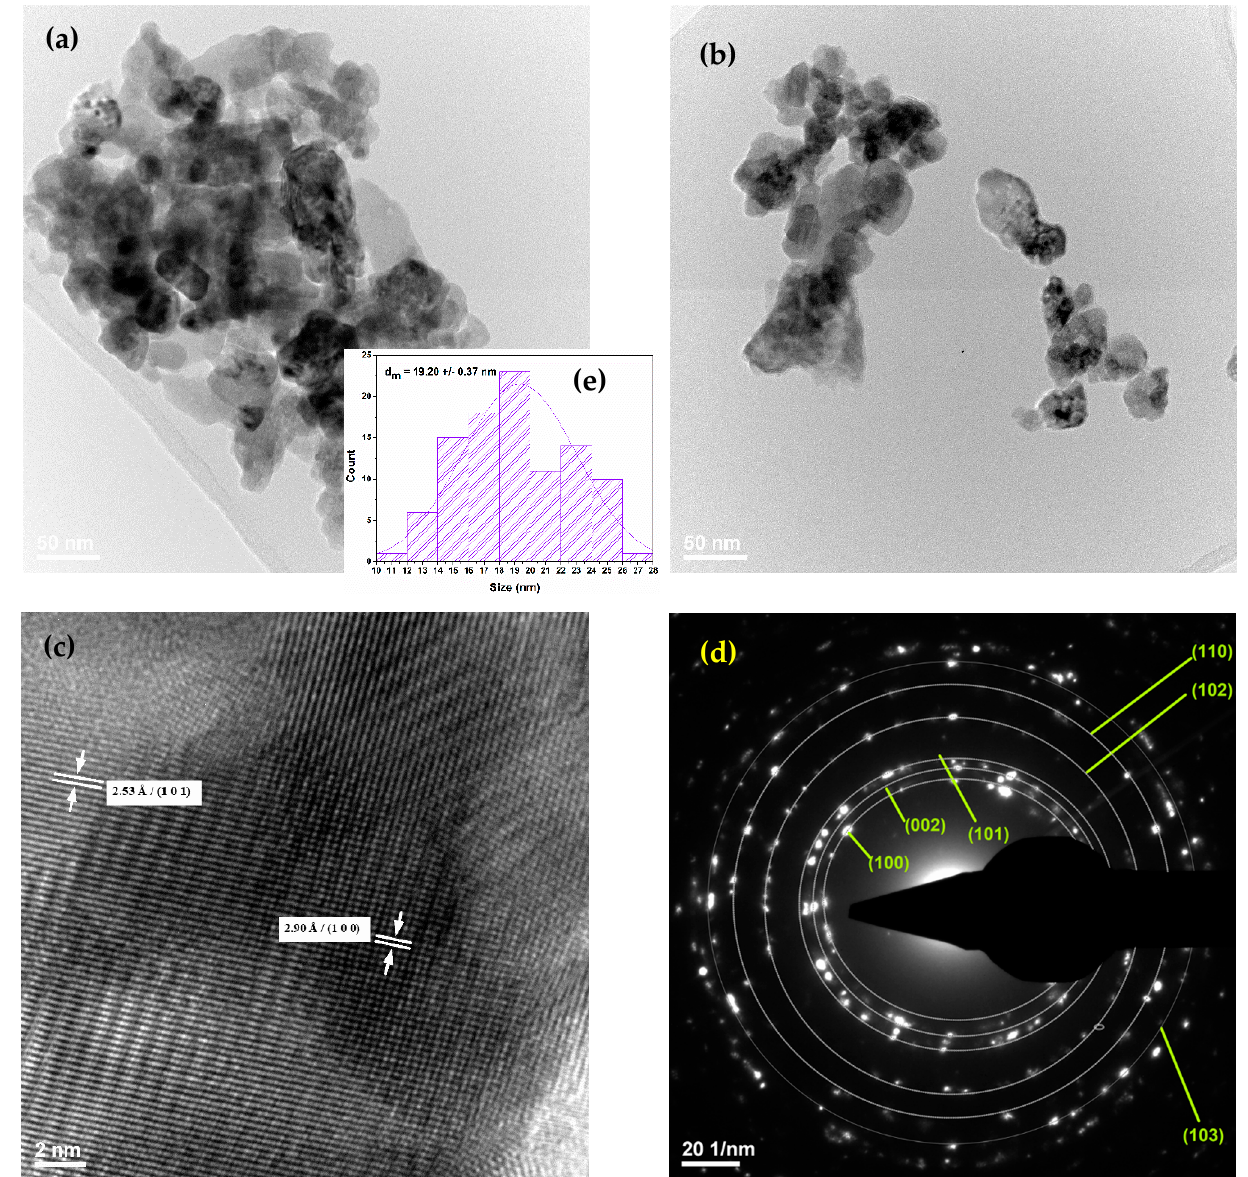
Figure 3. ( a , b ) TEM images; ( c ) HRTEM image; ( d ) SAED pattern of ZnO@LiN nanoparticles; ( e ) histogram of particle size- distribution.